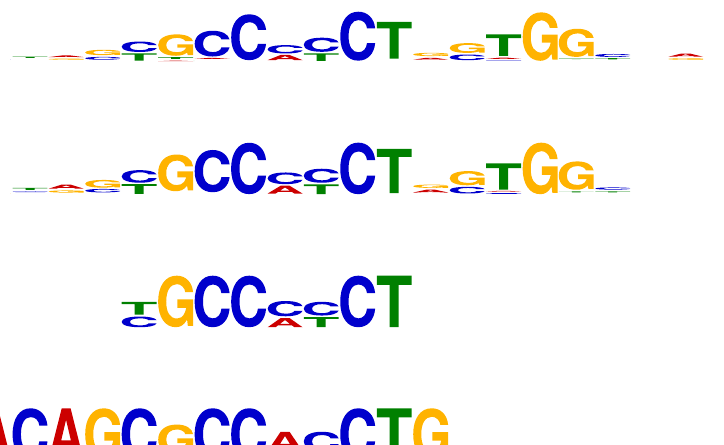
Figure 1. Logos for CTCF motifs. First: The reverse complement of the known CTCF motif from the JASPAR database (MA0139.1). Second: The motif recovered by STEME using the shuffled control sequences. STEME also recovers a near identical motif using the promoter control sequences. Third: The reverse-complement of the motif recovered by DREME using the shuffled control sequences. Fourth: One of the CTCF-like motifs recovered by Trawler using the promoter control sequences.